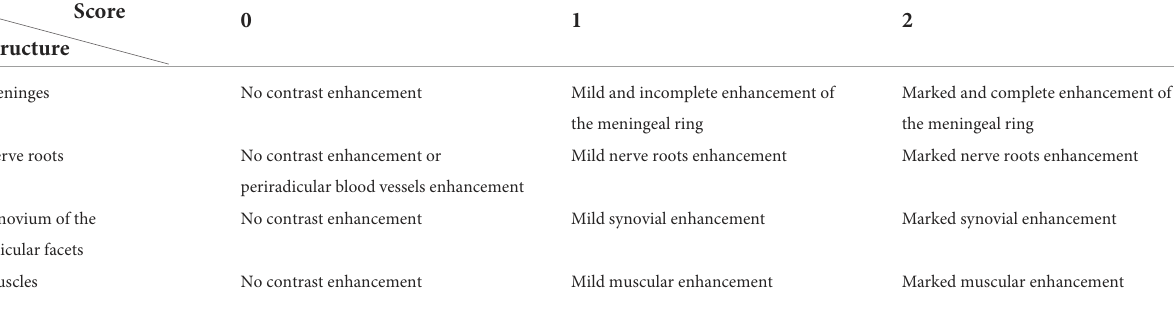
TABLE 1 Key to T1/T1 FAT-SAT contrast enhancement rating for each cervical structure analyzed in the study.